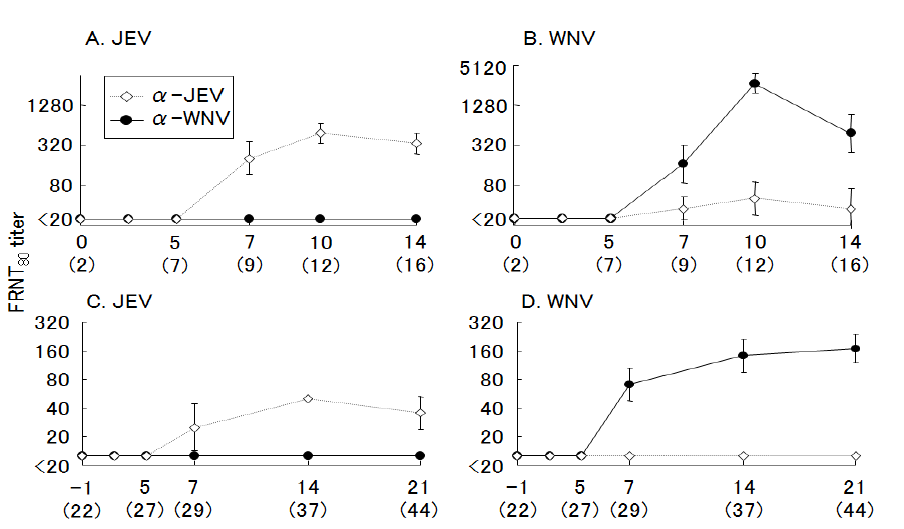
Figure 10. Primary neutralizing antibody responses in chicks inoculated with Japanese encephalitis (JE) and West Nile (WN) viruses. Two-day-old chicks ( n = 4) were inoculated with 100 plaque forming units (PFU) of ( A ) JE virus and ( B ) WN virus, and 3-week-old chicks ( n = 4) were inoculated with 1,000 PFU of ( C ) JE virus and ( D ) WN virus. Anti-JE virus ( ◇ ) and -WN virus ( ● ) neutralizing antibody titers were and are expressed as the mean ± SD. measured by FRNT 80